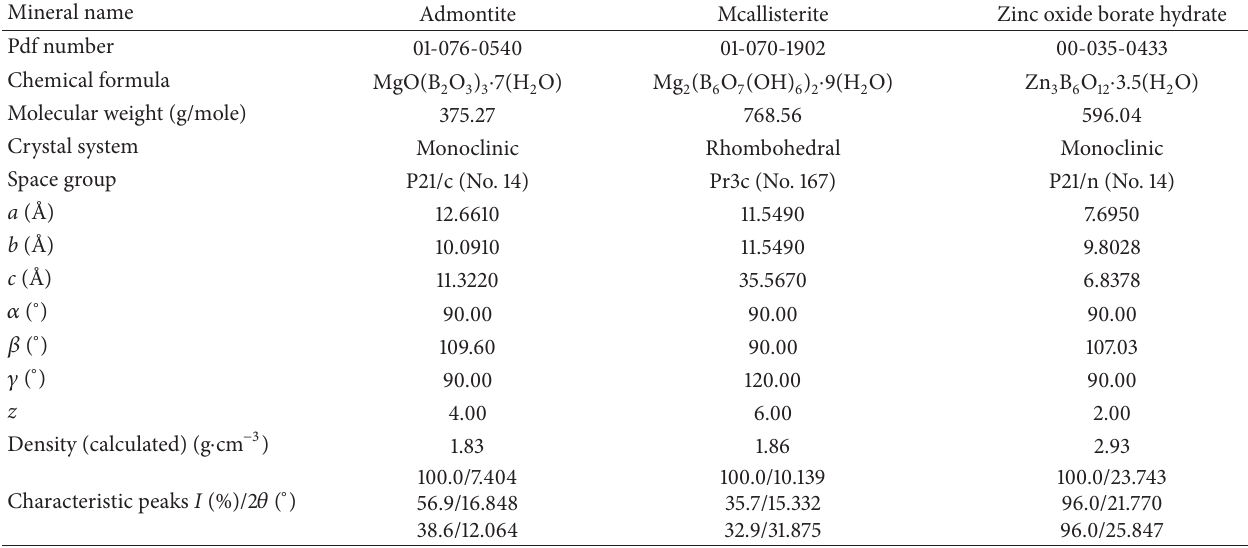
Table 4: Crystallographic data of the synthesised magnesium and zinc